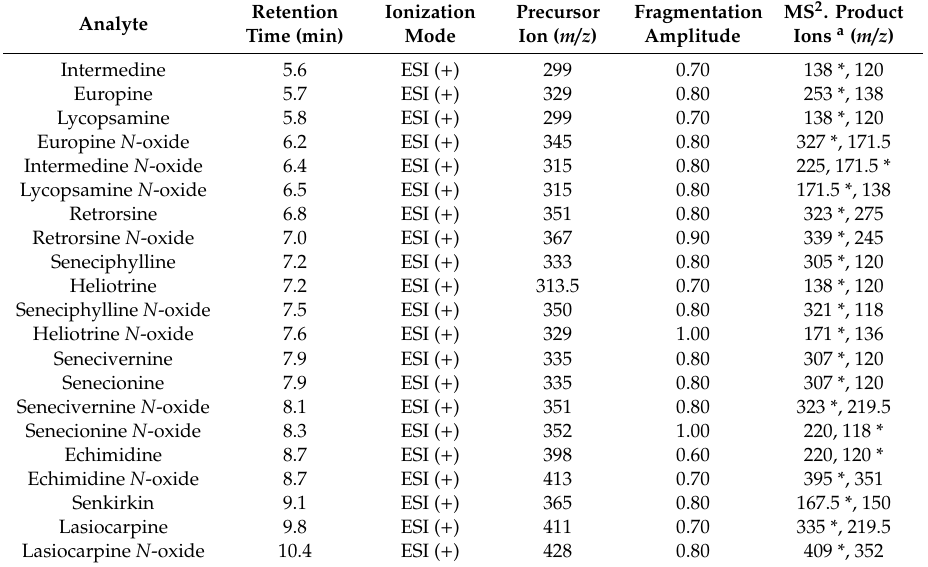
Table 1. Retention time and mass spectrum parameters of the targeted analytes using the UHPLC-IT-MS/MS method developed.